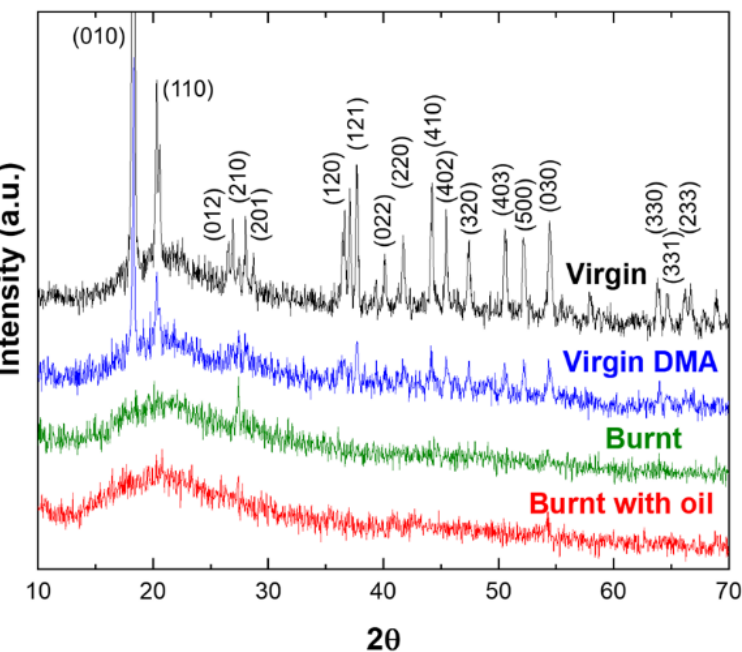
Figure 5. XRD spectral patterns of a virgin specimen and the virgin and burnt specimens after DMA testing (“Burnt” ≡ without contamination, “Burnt with oil” ≡ oil contaminated).